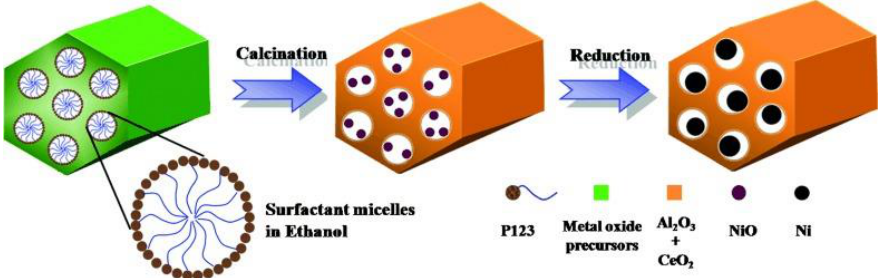
Figure 9. Schematic illustration of the NiCeAl (R) preparation. Reproduced with permission from reference